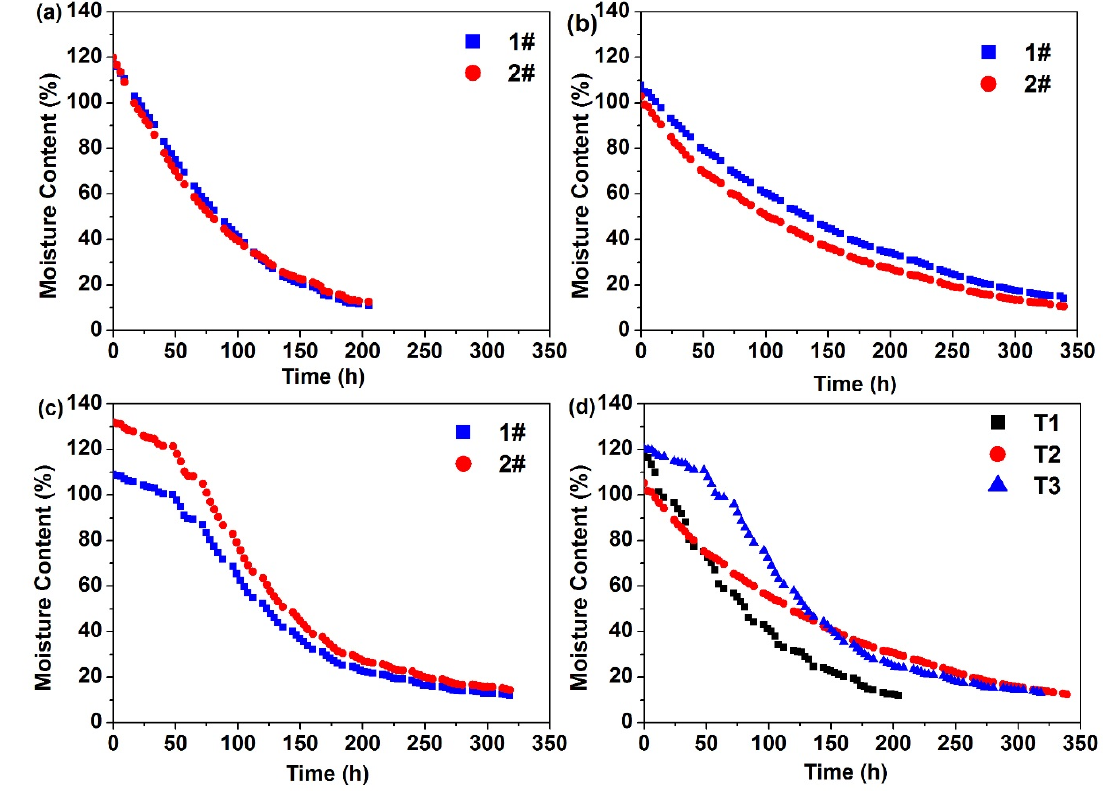
Figure 3. Curve depicting changes in the moisture content of T1, T2, and T3 during drying. 1# and 2# MC curves of T1 ( a ); 1# and 2# MC curves of T2 ( b ); 1# and 2# MC curves of T3 ( c ); Average MC curves of T1, T2, and T3 ( d ).